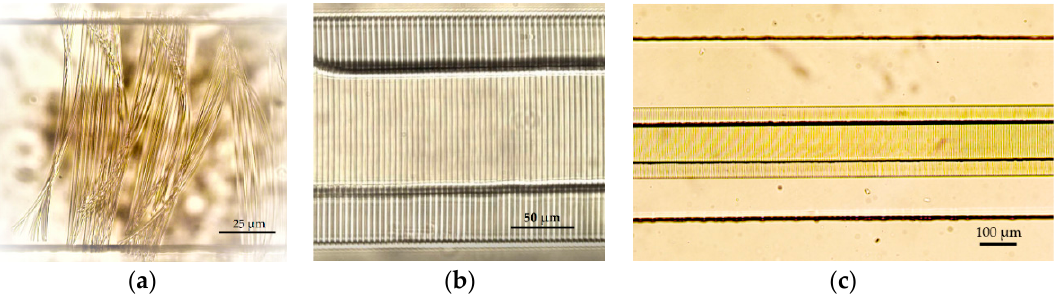
Figure 4. Optical images of laser-printed wire membranes for organ-on-a-chip application, where ( a ) is printed in the non-fully cured photoresist; ( b ) is a successfully printed structure in the closed microfluidic channel 100/500 µm with optimally cured photoresist and ( c ) is a 3D laser lithography (3DLL)-made wire membrane over a 1 cm long microfluidic channel.